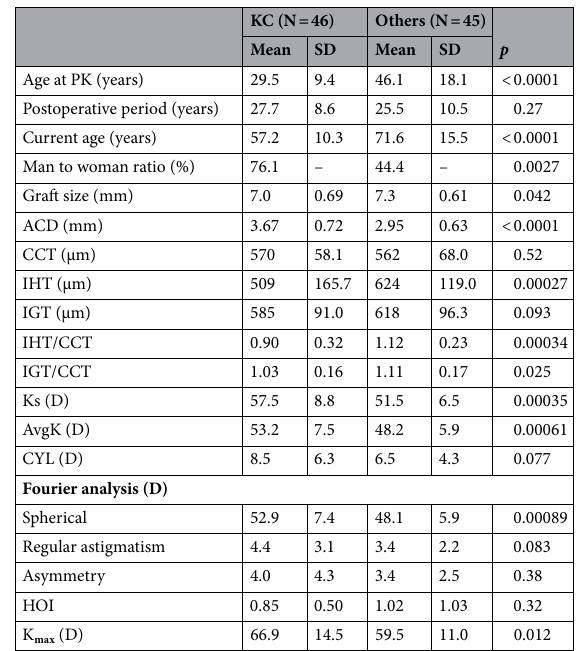
Table 1. Patient characteristics and measured parameters in the KC and Others groups. KC keratoconus, PK penetrating keratoplasty, ACD anterior chamber depth, CCT central corneal thickness, IHT inferior thinnest host cornea thickness, IGT inferior thinnest graft thickness, IHT/CCT IHT ratio to CCT, IGT/CCT IGT ratio to CCT, Ks steepest corneal power, D diopters, AvgK average corneal power, CYL cylinder, HOI higher order irregularity, K max Maximum corneal power.